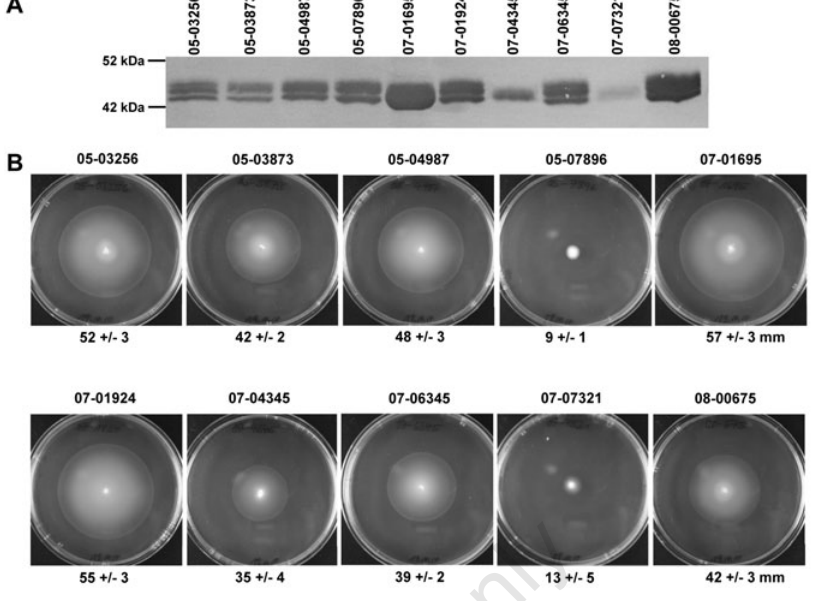
Figure 2. Secretion of flagellins by Y. enterocolitica biotype 1A strains and motility on floating agar. (A) TCA-precipitated proteins from the culture supernatant of Y. enteroco-